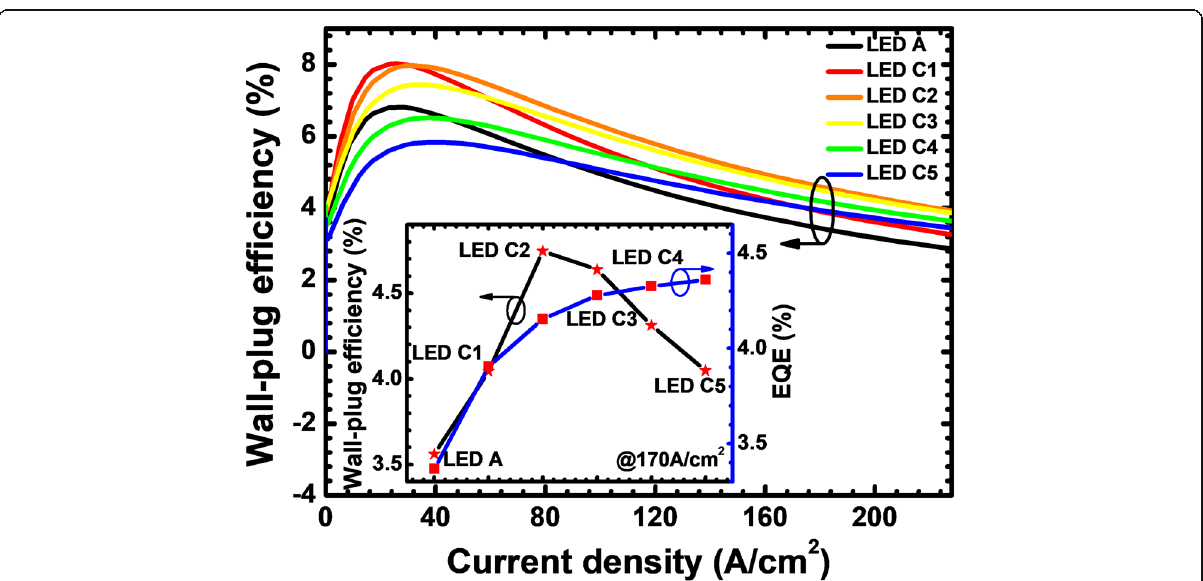
Fig. 17 WPE as a function of the injection current for LEDs A, C1, C2, C3, C4, and C5. Inset figure shows the WPE and the EQE for the studied LEDs with various AlN compositions for the n-AlGaN layer at the current density of 170 A/cm